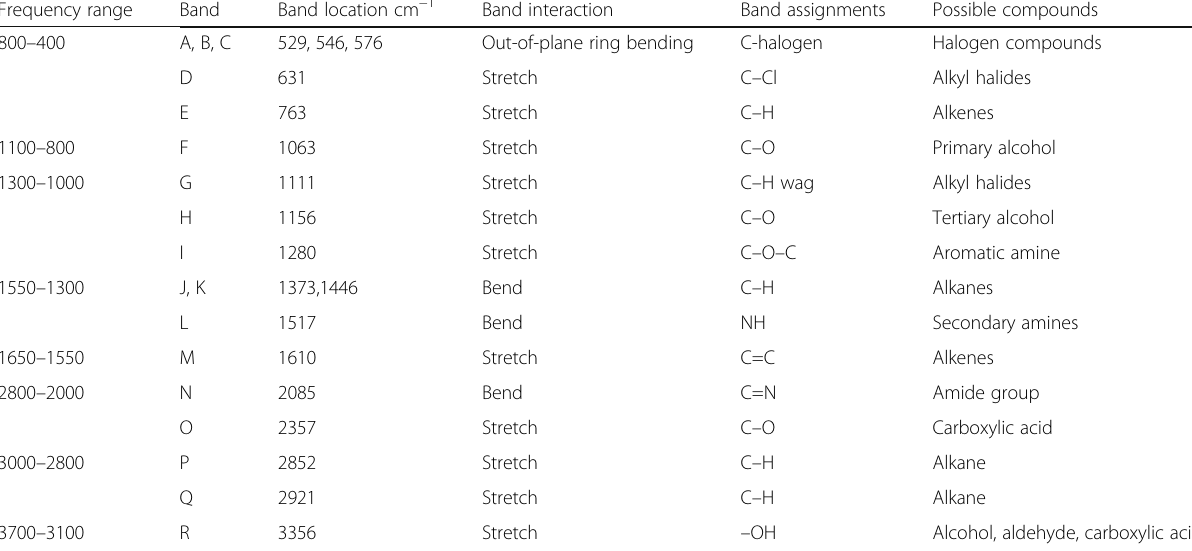
Table 3 FT-IR analysis revealed the presence of functional groups in the Sterculia urens Roxb. root Frequency range